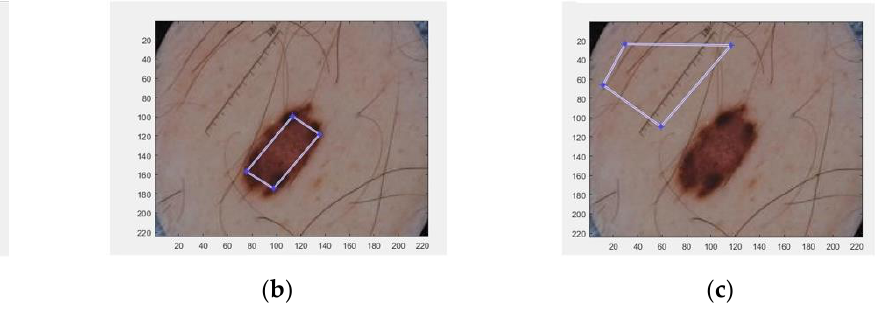
Figure 1. Selected areas of dermoscopic images for calculating the histograms. ( a ) Original image; ( b ) Selected region inside the lesion; ( c ) Selected region in the healthy skin.